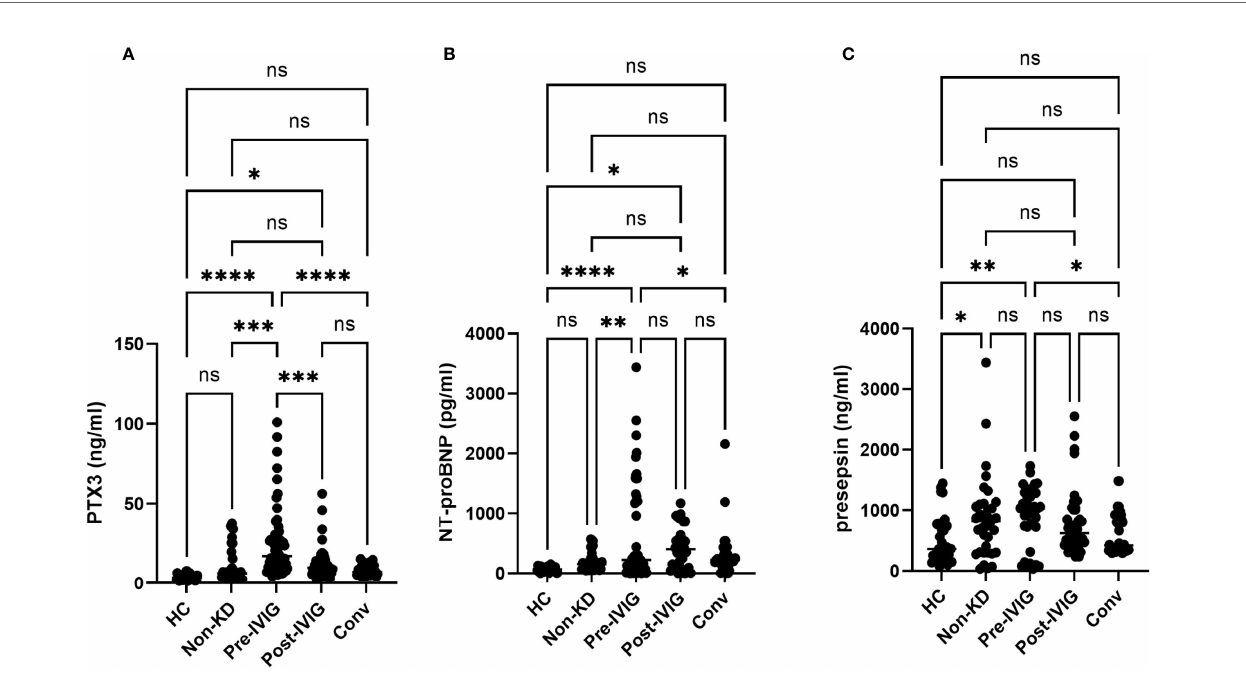
FIGURE 1 | Plasma levels of PTX3, NT-proBNP and Presepsin during the disease course of KD. Unpaired Student t-test. Comparison of the level of PTX3 (A) , NT-proBNP (B) , and Presepsin (C) in healthy non-febrile controls, non-KD febrile controls, and KD. Between-group differences were determined using ANOVA and logical regression analysis. A: Circulating levels of PTX3 throughout KD. B: Circulating levels of NT-proBNP throughout KD. C: Circulating levels of Presepsin throughout KD. ns, not signi fi cant; * p < 0.05, ** p < 0.01, *** p < 0.005, **** p < 0.001. HC, healthy controls; Non-KD, non KD febrile disease; at the time of onset of KD or before IVIG (Pre-IVIG), after IVIG (Post-IVIG); Conv,